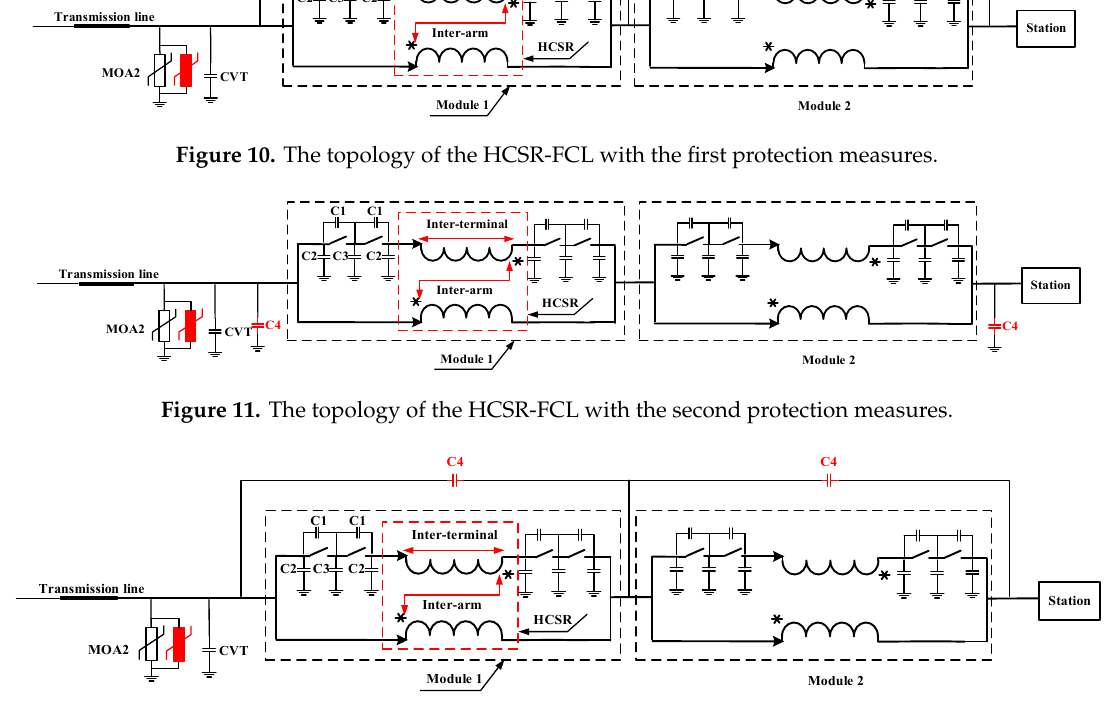
Figure 12. The topology of the HCSR-FCL with the third protection measures.